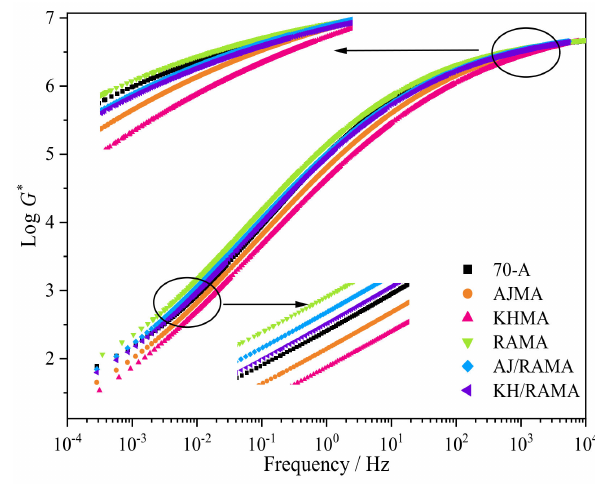
Figure 8. Master curve of asphalt complex shear